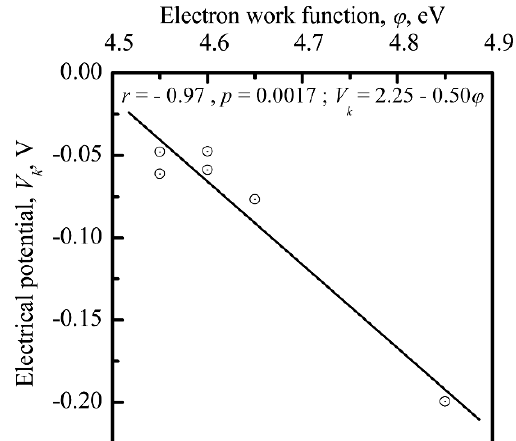
Figure 14. Relationship between the EP ( V k ) and the electron work function ( φ ) of the CP surface at the nanoscale level.